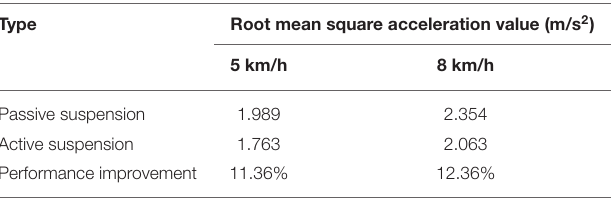
TABLE 4 | Comparison of root mean square acceleration values of sprayers at different speeds on E-grade road.